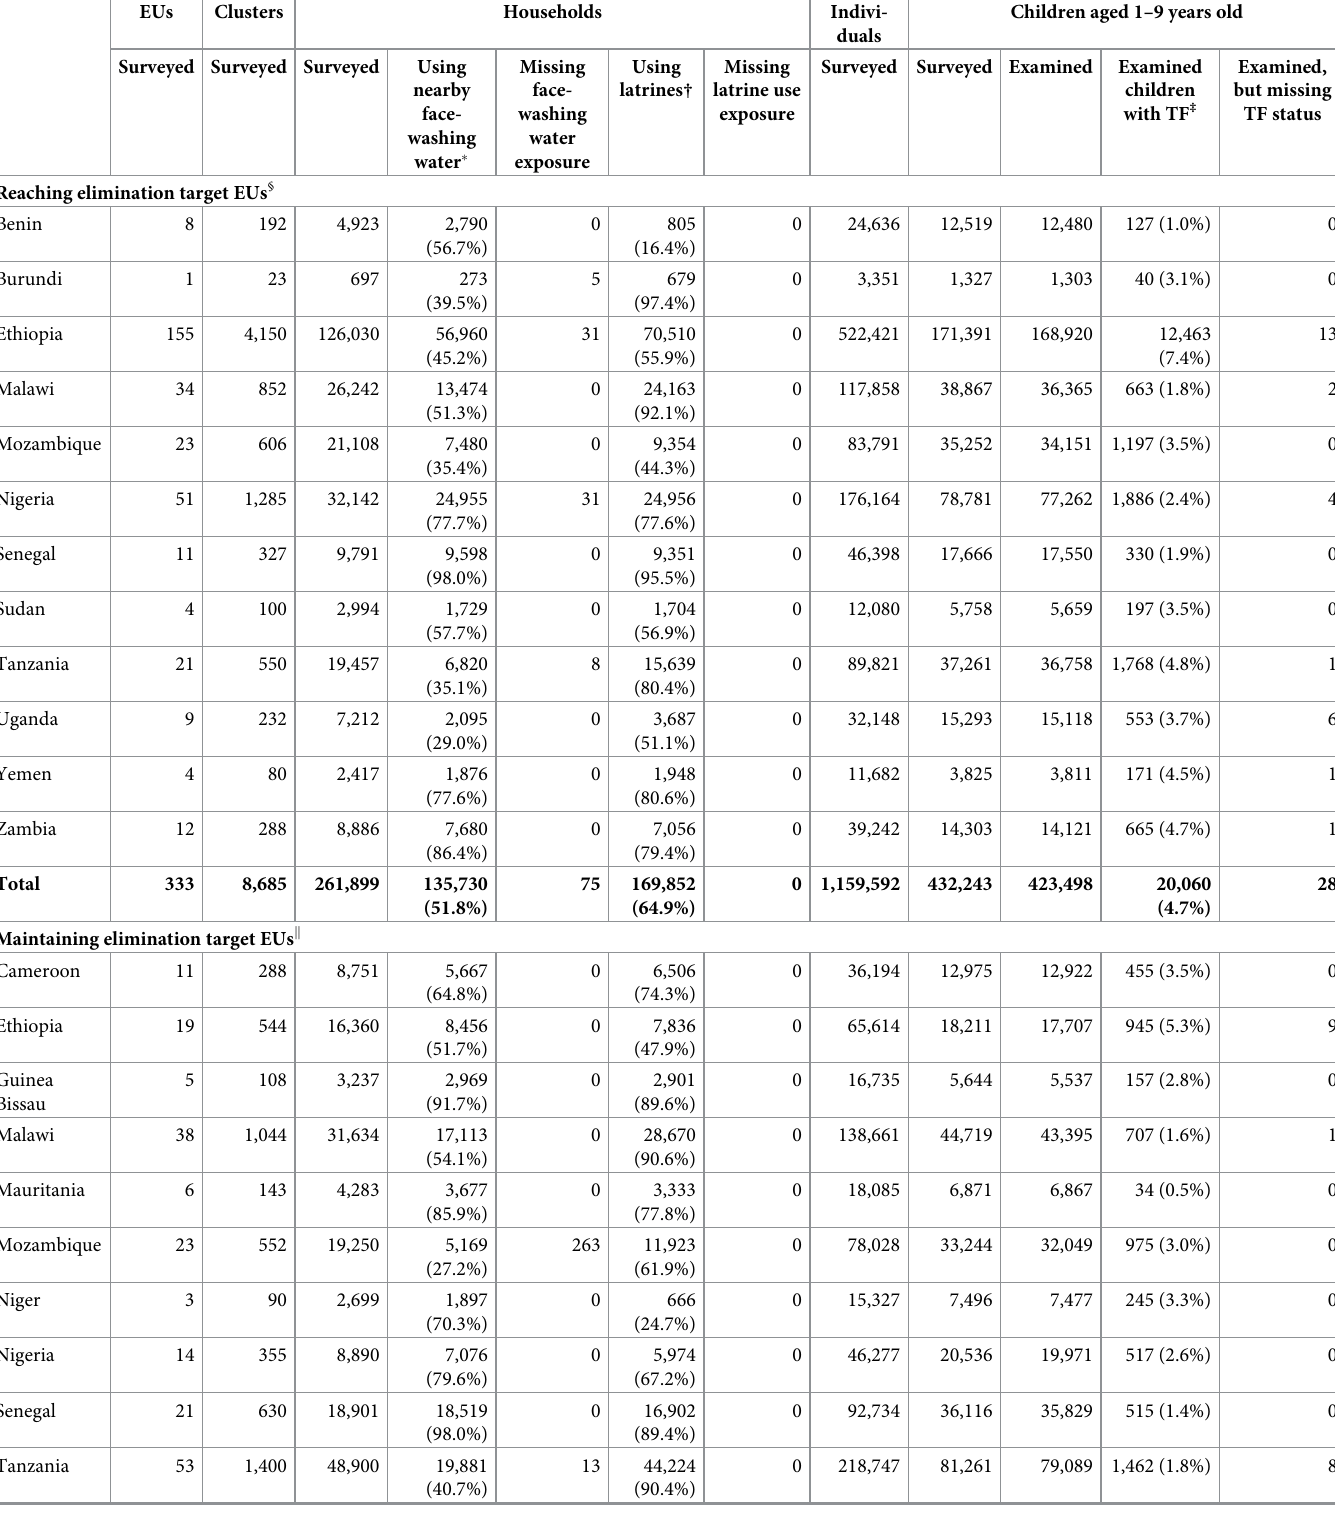
Table 1. Characteristics of study EUs, clusters, households, and individuals.